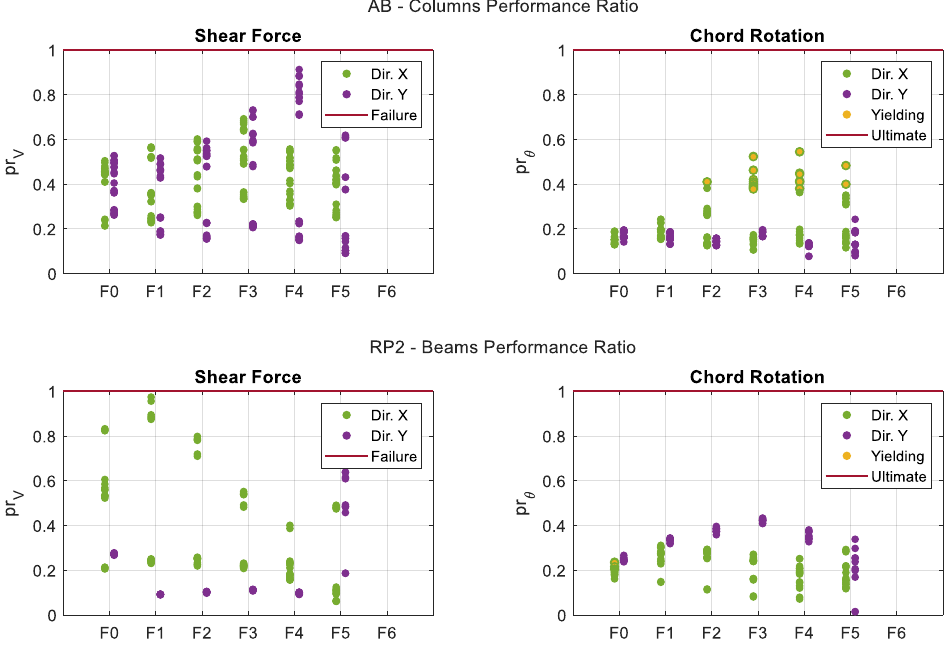
Figure 16. RP2 RC elements and infill panels performance ratios.